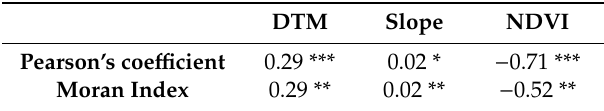
Table 8. Correlation between CWSI and variables DTM, Slope and